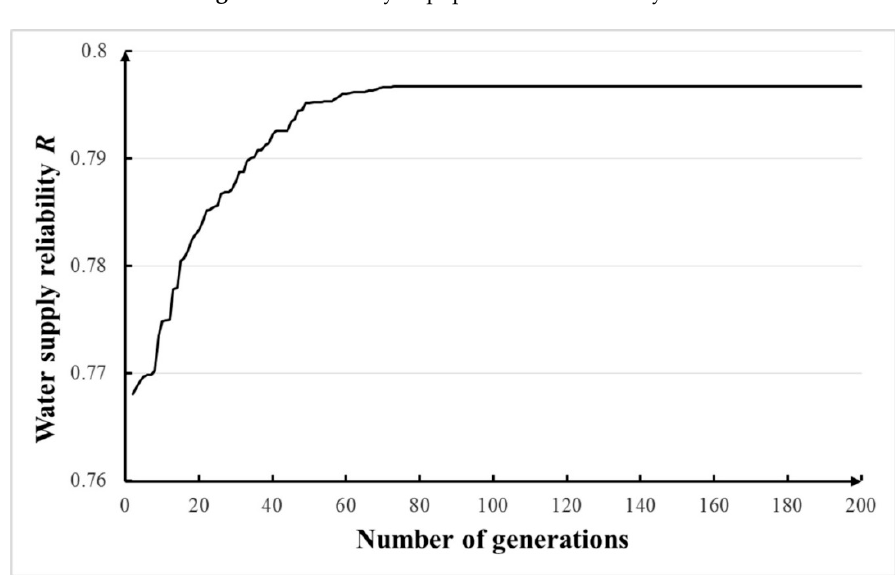
Figure 8. Sensitivity of number of generations in noisy GA.